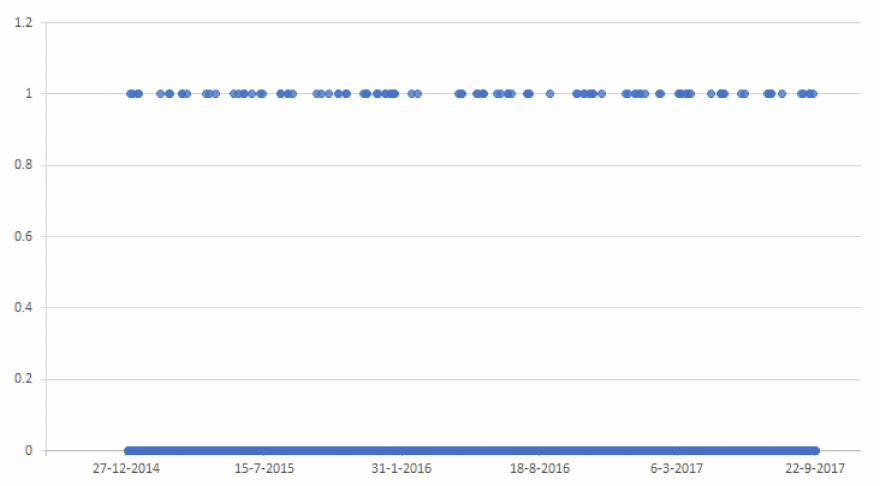
Figure 4. The time series of the spikes/non-spikes instances. Every spike is coded with 1 and every non-spike with 0.